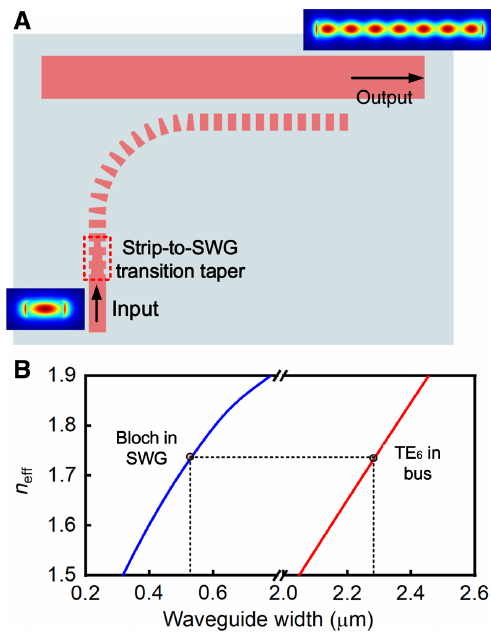
Figure 9: High-order mode (de)multiplexer employing SWG waveguides. (A) Schematic diagram of the (de)multiplexer structure. (B) Effective